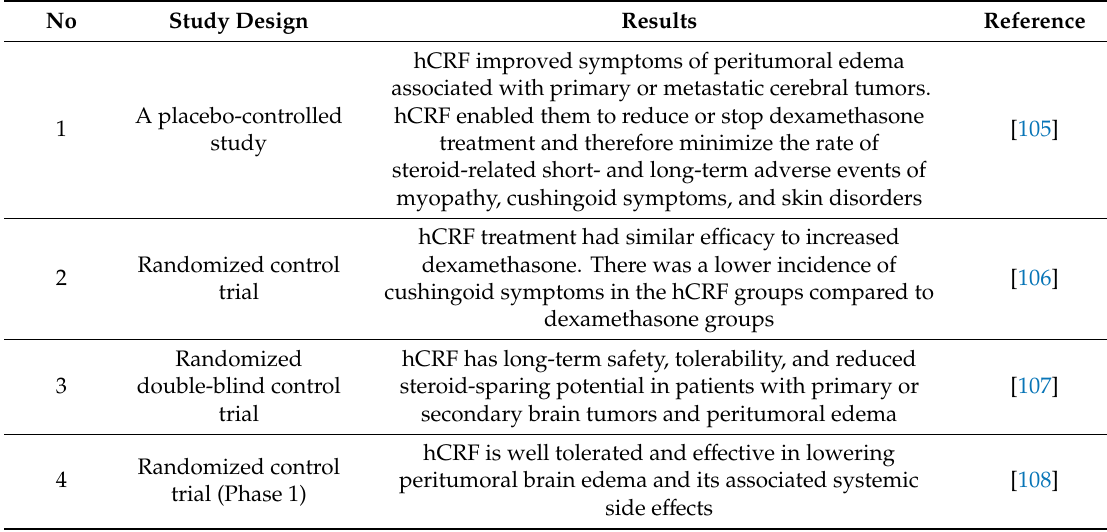
Table 2. Summary of clinical trials using hCRF for managing edema in patients with brain tumor.